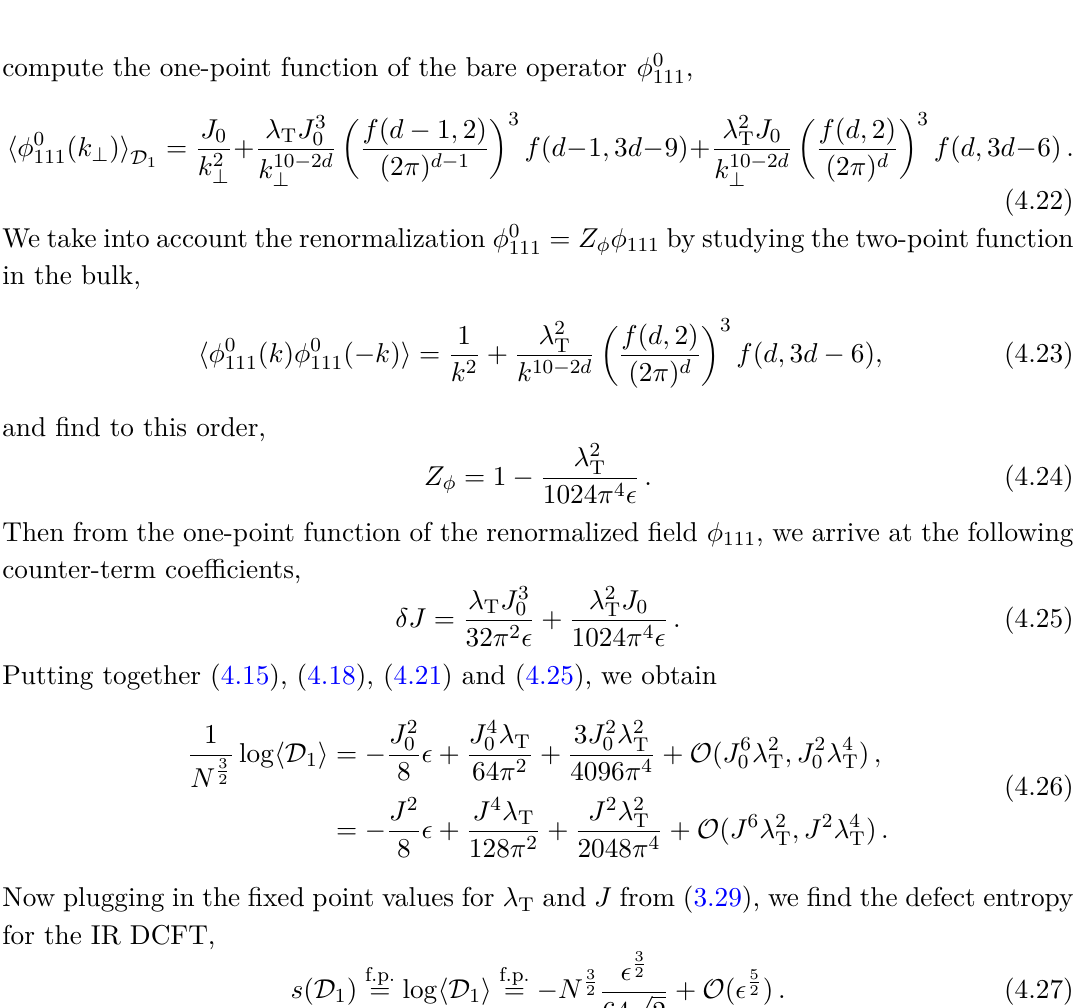
Figure 8 . The diagrams that contribute to the counterterms for the defect coupling